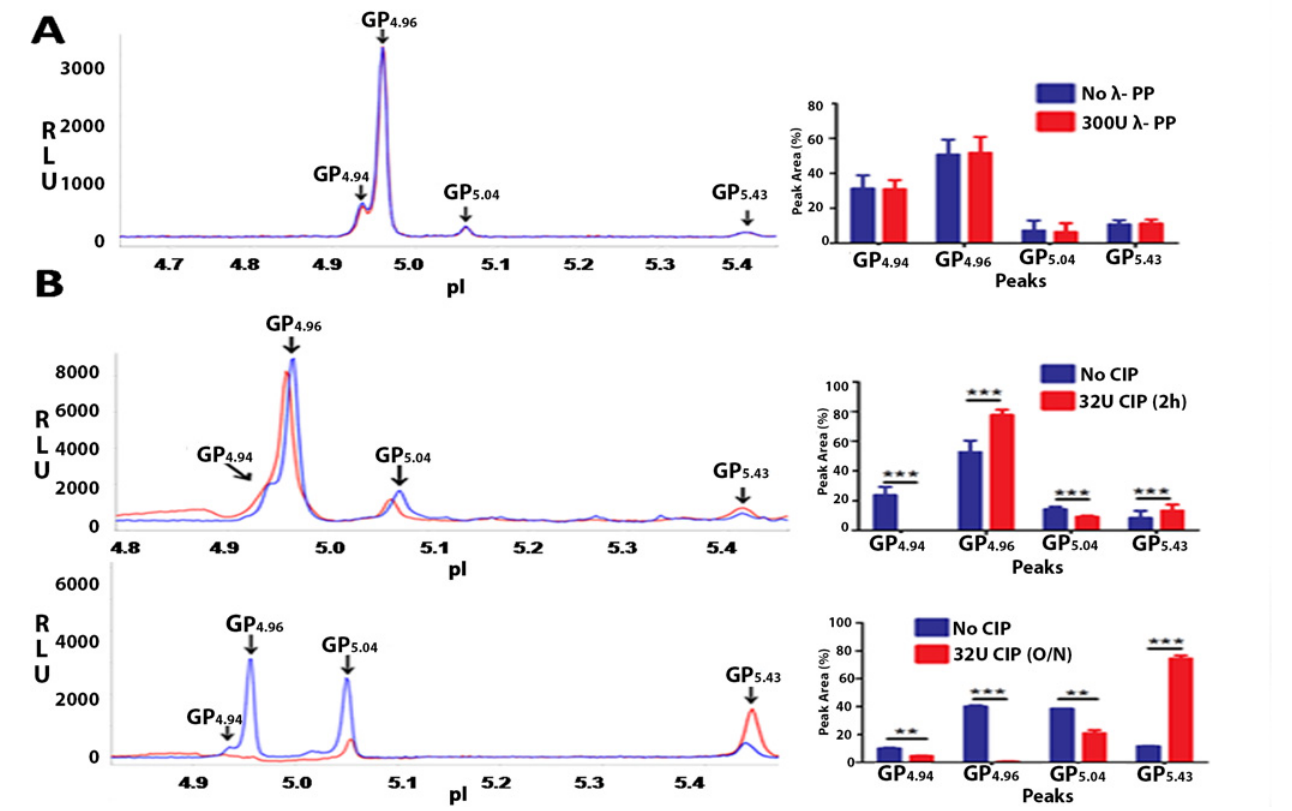
Fig 7. Phosphorylated forms of GRP78 in human sperm. Phosphorylated forms of GRP78 in human sperm were discerned using λ -PP and CIP. Figure shows representative isoelectropherograms of NIA profiles for Normal human sperm post λ -PP (A) and CIP (B) treatment. 100 μ g of human sperm protein was incubated without or with 300U of λ -PP for 2h at 30°C. For CIP treatment, reactions were incubated for 2h or overnight at 37°C. 20ng of this protein was used for NIA. No significant change was observed in the peak profile post λ -PP reaction (A) . On CIP treatment (2h incubation), complete reduction was observed in GP 4.94 and significant reduction in GP 5.04 . Significant increase was observed in GP 4.96 and GP 5.43 [Fig B; upper panel]. On overnight incubations with CIP, significant reduction was observed in GP 4.94 and GP 5.04 . GP 4.96 was completely reduced and a significant increase was observed in the unphosphorylated form GP 5.43 [Fig B; lower panel]. Values are expressed as mean ± SD. Graphical representations of the cumulative data for GRP78 peak profiles in sperm post λ -PP / CIP treatments are